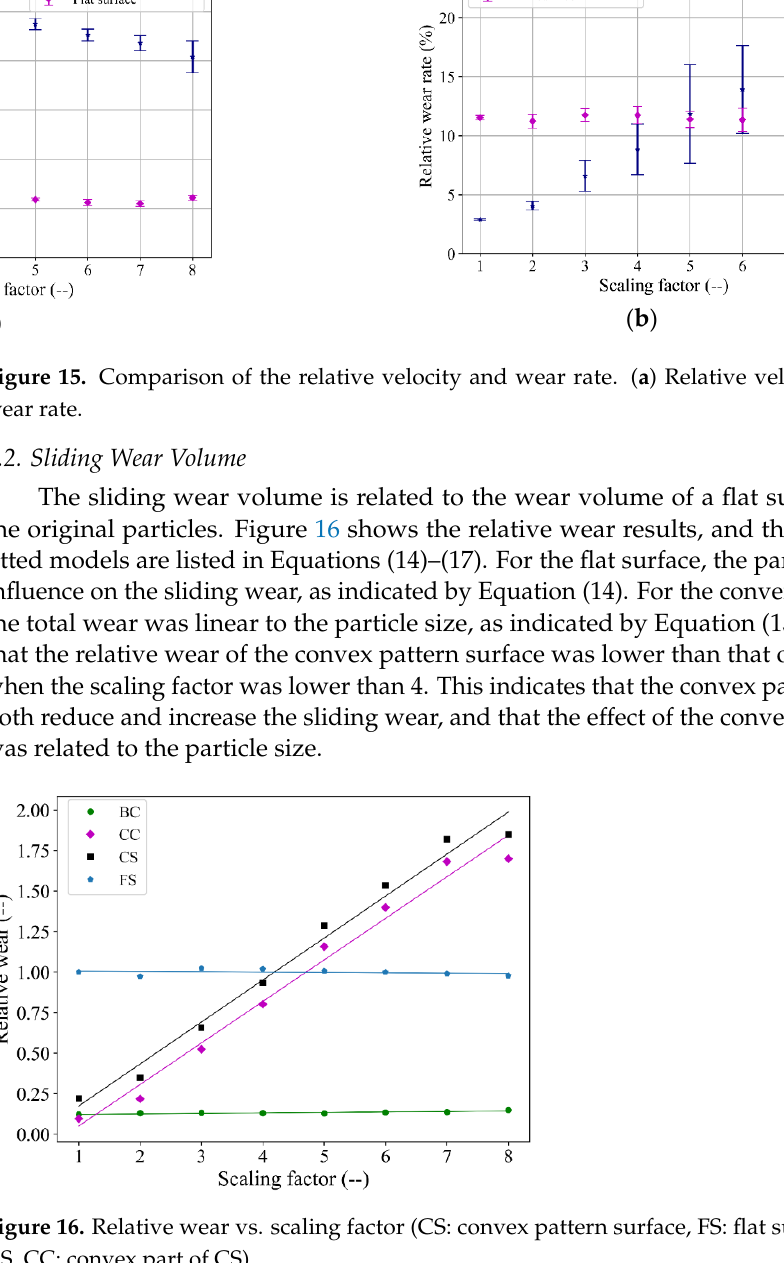
Figure 16. Relative wear vs. scaling factor (CS: convex pattern surface, FS: flat surface, BC: base of CS, CC: convex part of CS).